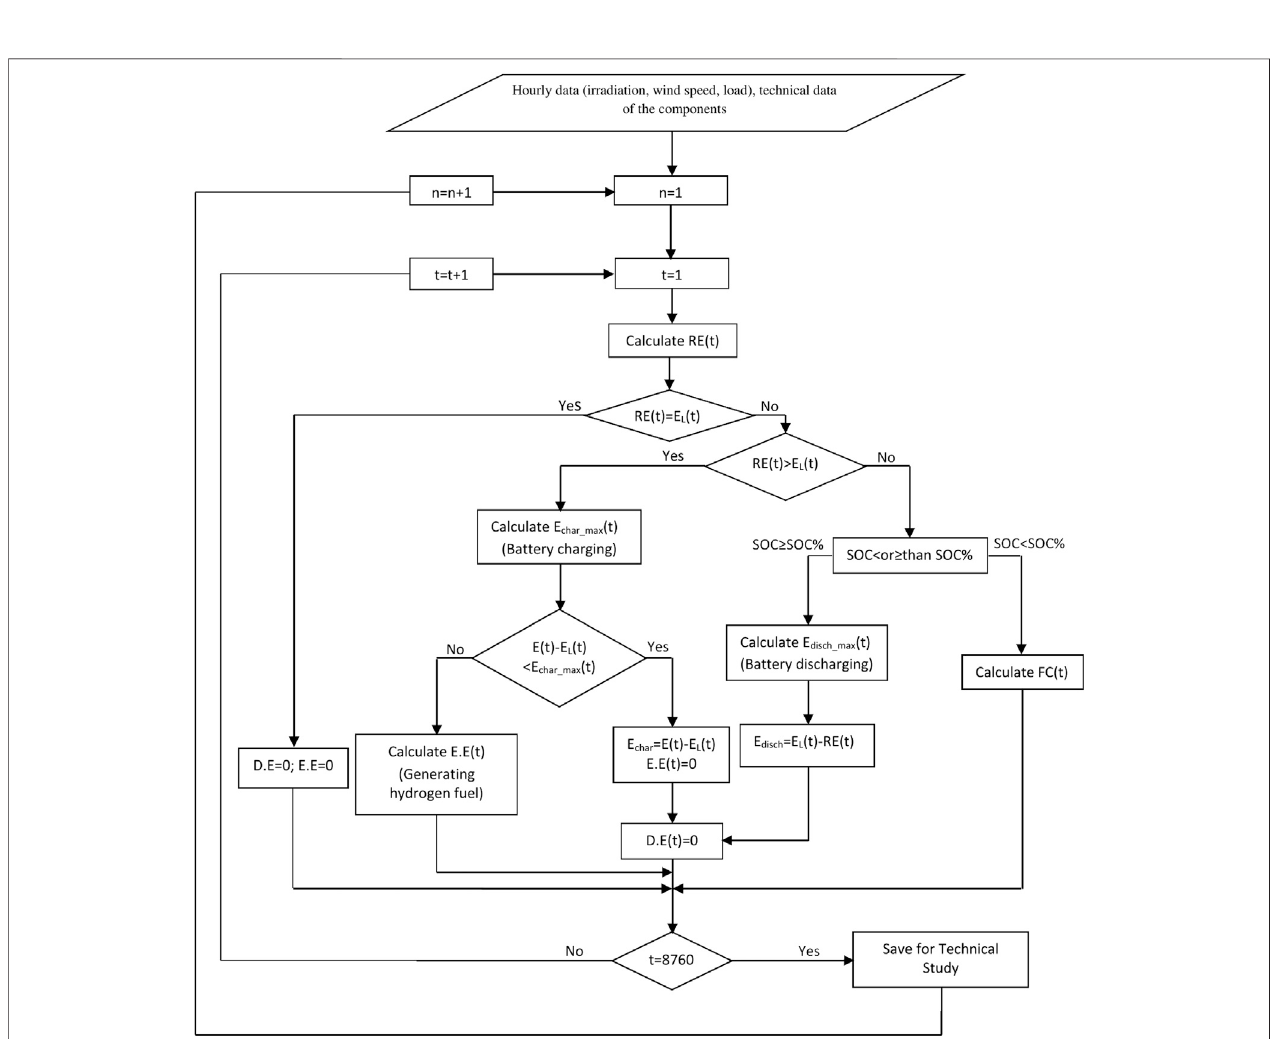
FIGURE 2 | Algorithm for integrated PV/wind/battery/fuel cell system (Ahmed et al., 2010; Ani, 2015).